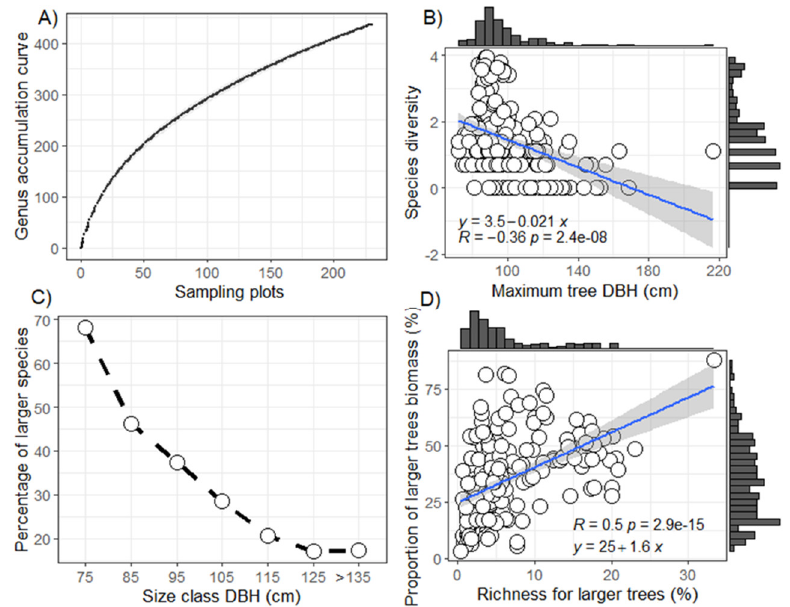
Figure 3. Richness and diversity estimates and their relationship with dendrometric attributes of the big trees. Panel ( A ) shows the species accumulation curve by sampled area. Panel ( B ) shows the relationship of species diversity with the largest diameters per plot. Panel ( C ) indicates the percentage of species by diameter class. Panel ( D ) shows the proportion of biomass of the big trees in relation to the percentage of species richness of big trees per plot. Marginal histograms indicate frequency.